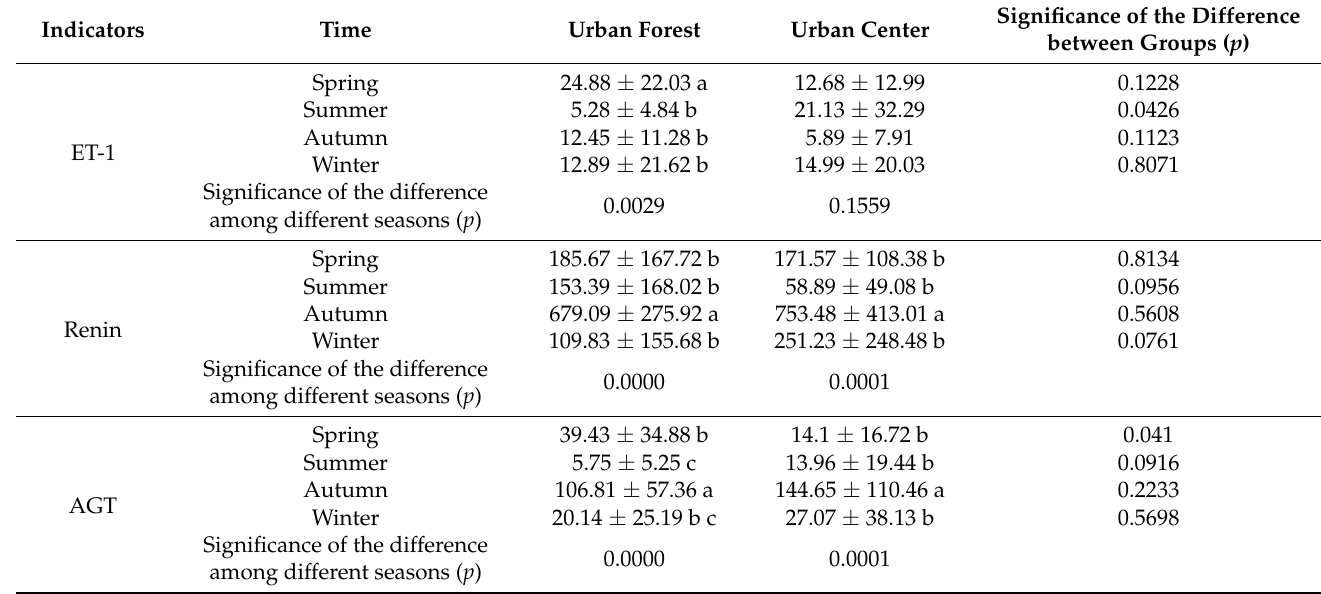
Table 3. Effect of forest bathing on cardiovascular disease-related pathological factors of participants among different seasons, analyzed by Kruskal–Wallis test. Mean values ± standard deviation. Lowercase letters (a, b, c) in the same column indicate significant differences ( p < 0.05 using Kruskal– Wallis test) among different seasons.